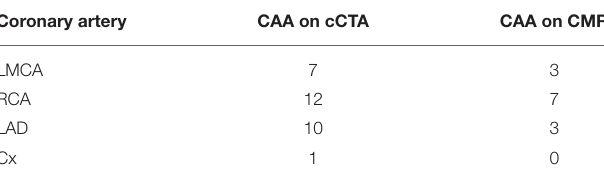
TABLE 2 | Total CAAs detected by cCTA vs CMR. Coronary artery